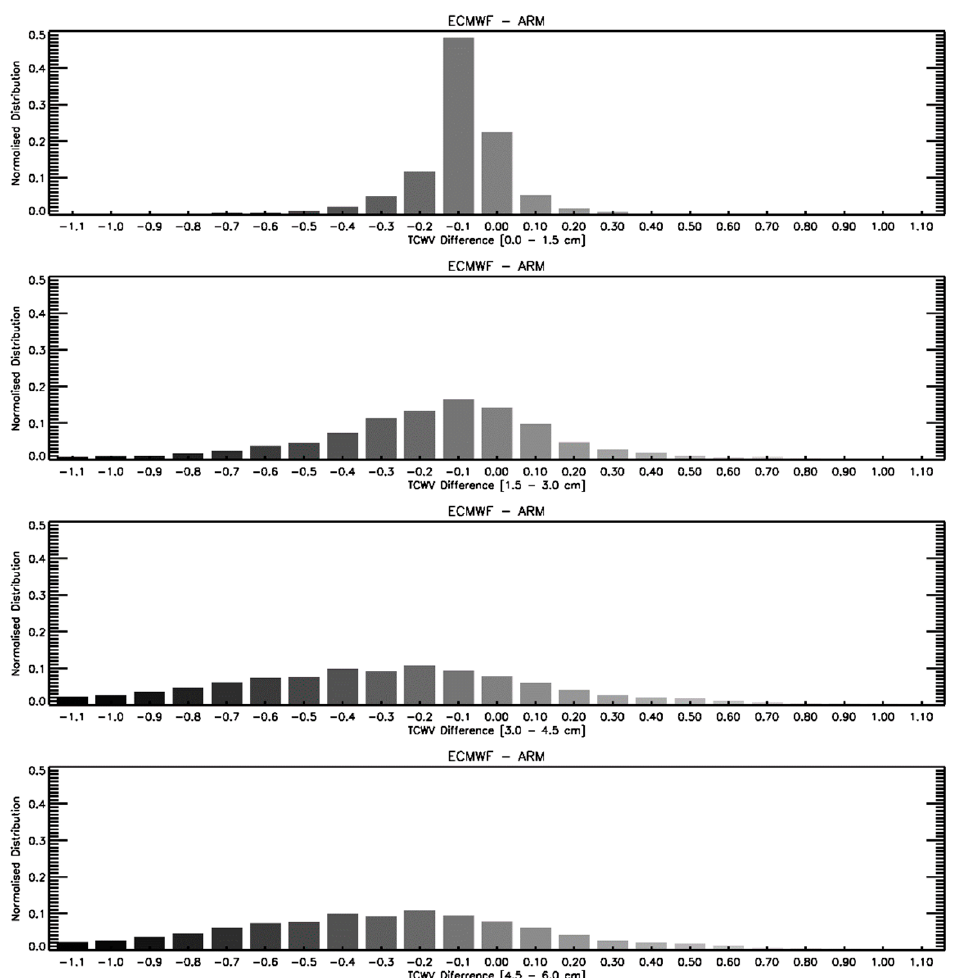
Figure 1. Comparison of European Centre for Medium-Range Weather Forecasts (ECMWF) against water vapour from the Atmospheric Radiation Measurement (ARM) Network for January 2002 to December 2012. The differences are banded into water vapour bands of 0.0–1.5 cm (first row), 1.5–3.0 cm (second row), 3.0–4.5 cm (third row) and 4.5–6.0cm (fourth row).